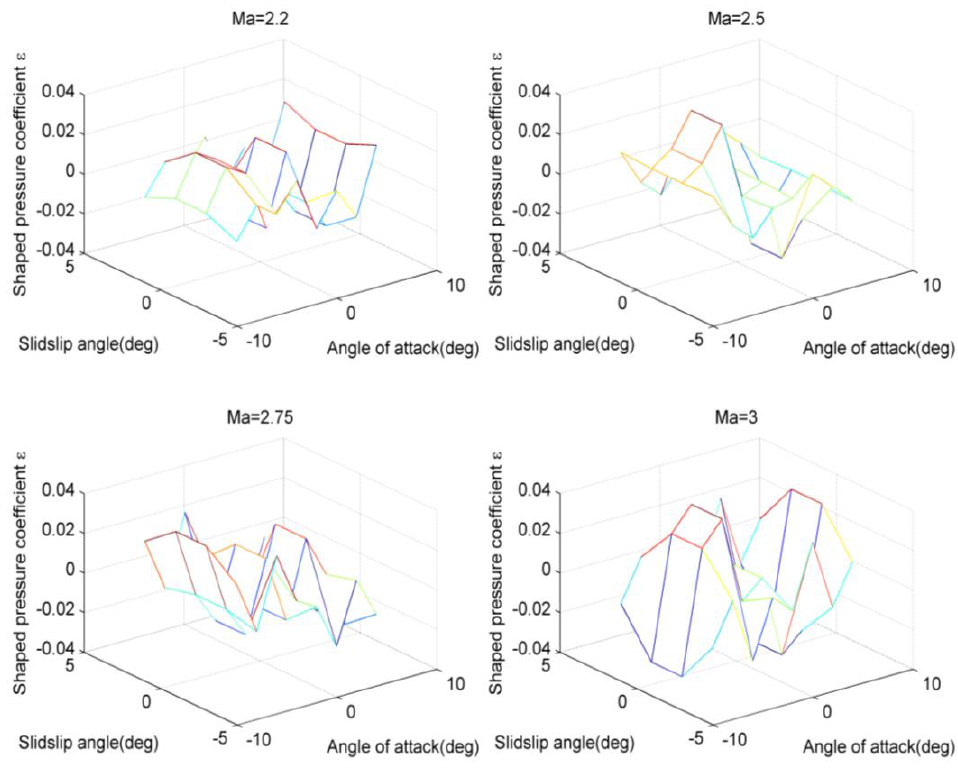
Figure 6. Change curves of angle errors of attack using neural network.